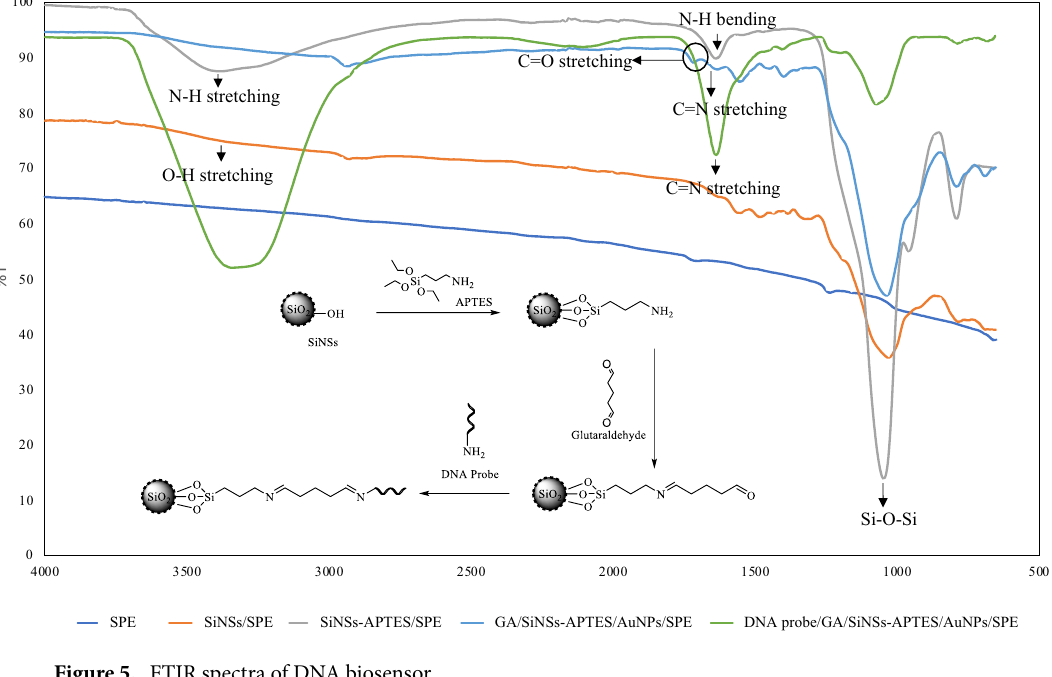
Figure 5. FTIR spectra of DNA